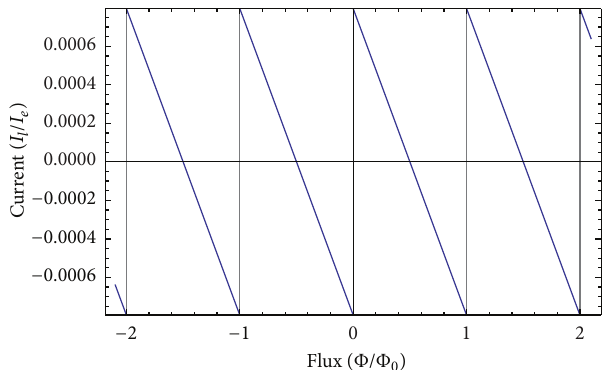
Figure 3: Variation of current with flux for 𝑅 = 10 𝑟 𝑒 and 𝑚 = 1𝑚 𝑒 . Here we have used the same unit system as Figure 2 and current is measured in units of 𝐼 𝑒 = 𝑒𝑐/𝑟 𝑒